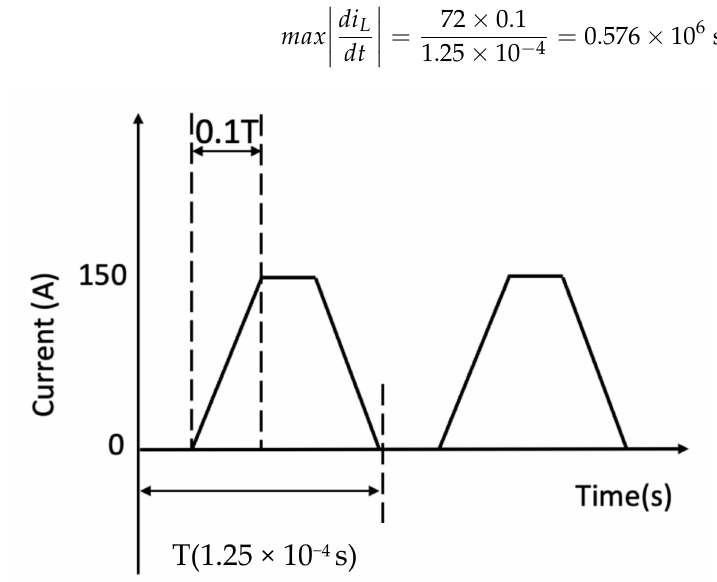
Figure 4. Theoretical input current rate of change after passive